Question: Compose a caption that would accompany this figure in a paper.
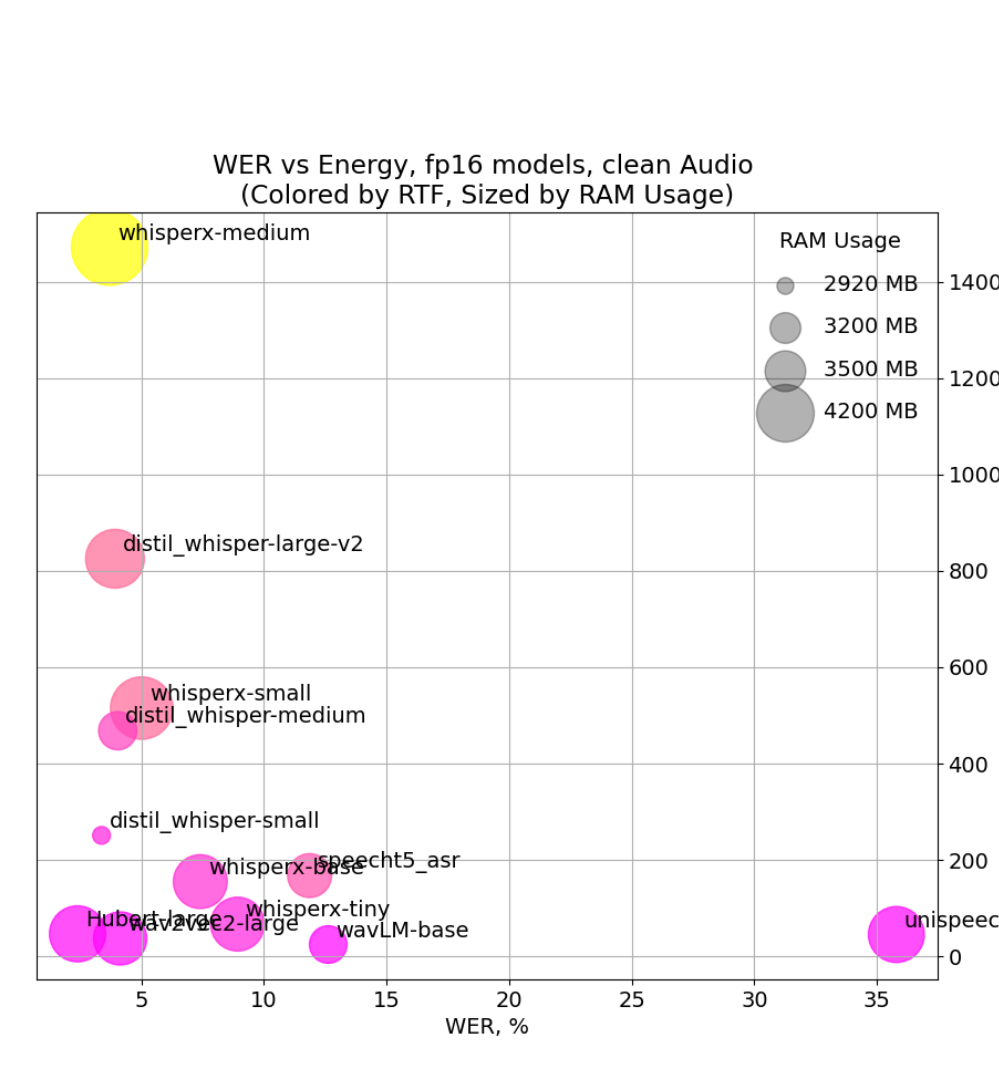
Answer: Scatterplot of word error rate and energy consumption for clean audio.